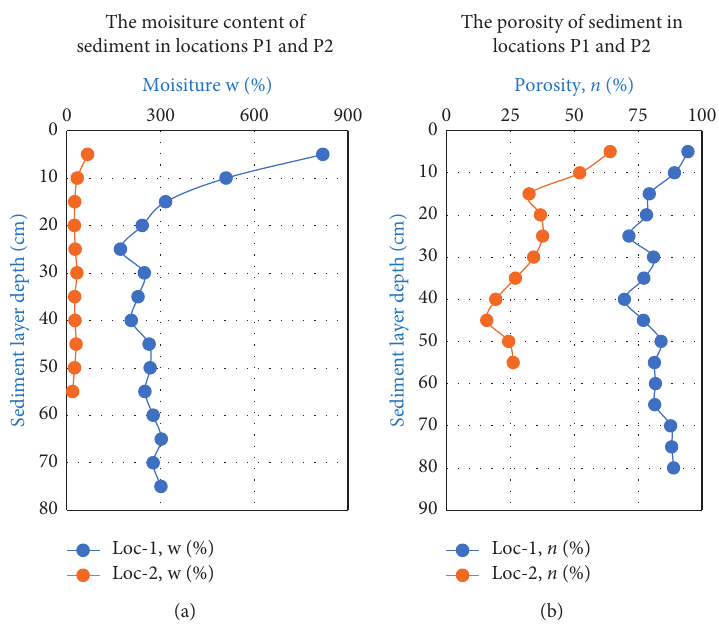
Figure 2: Variation of sediment moisture and porosity along with the core